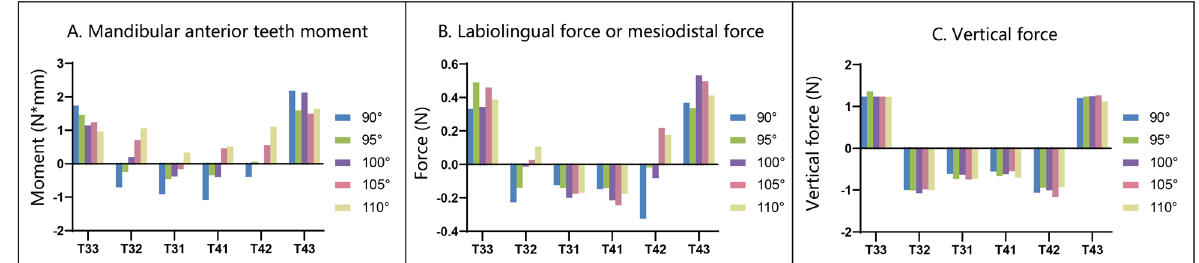
Fig. 3 Comparison of the force pattern of the bilateral identical teeth. Mandibular bilateral identical teeth were symmetrical in moment, mesiodistal force, labiolingual force, and vertical force. A . The mandibular anterior tooth moment: The mandibular left canine (33) and mandibular right canine (43) received distal crown moment basically without difference. The labial crown moment of the mandibular left central incisor (31), mandibular right central incisor (41), mandibular left lateral incisor (32), and mandibular right lateral incisor (42) were symmetrical. B . The labiolingual or mesiodistal force: CR of 33, 43 received force toward mesial direction without difference. 31, 32, 41, and 42 received labiolingual force without difference. C . The vertical force: 33 and 43 were subjected to the extrusive force without difference. 31, 32, 41, and 42 were subjected to the intrusive force without